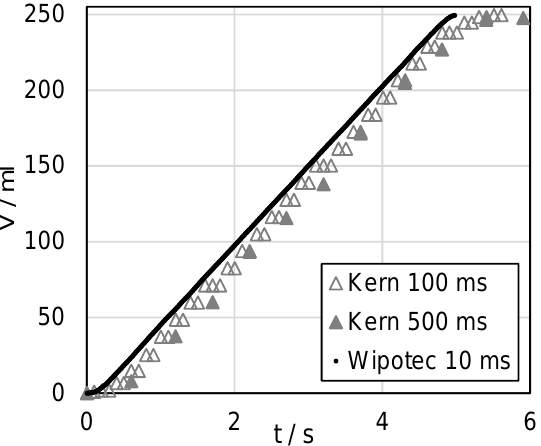
Figure 7. Effects of the balance. Membrane measured with 0 m% at 0.8 bar